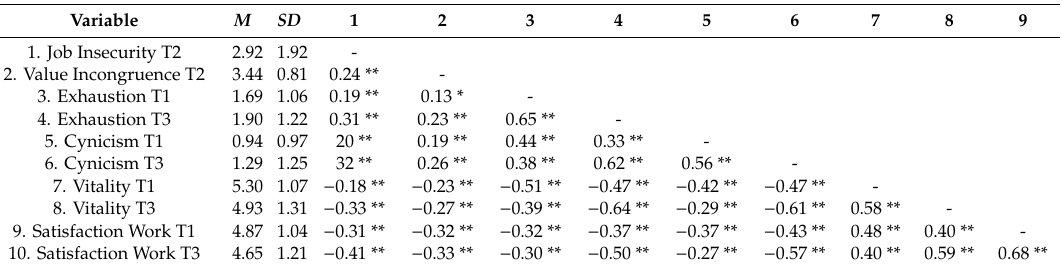
Table 2. Correlation matrix among